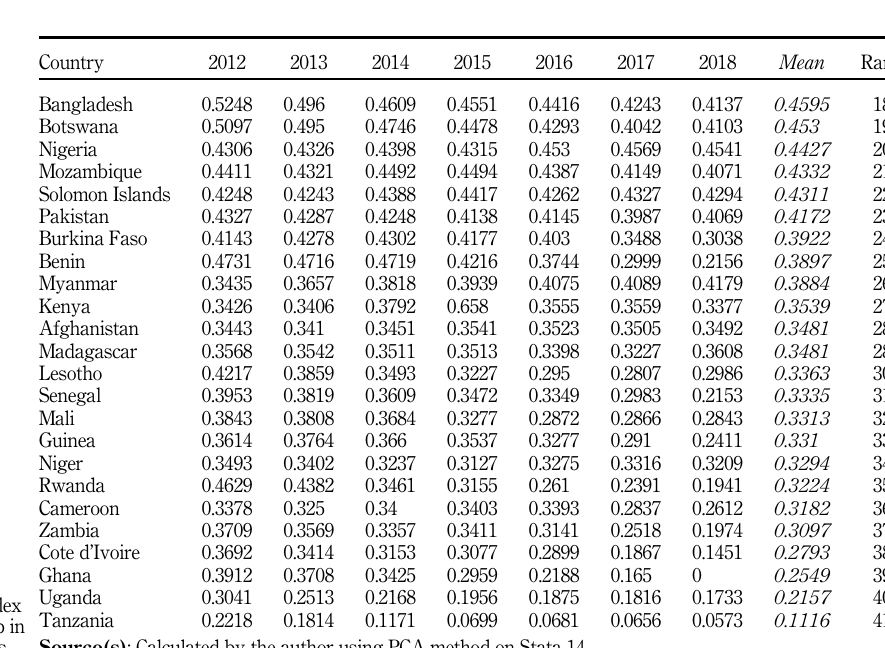
Table 6. Estimation of FI Index of low FI level group in developing countries